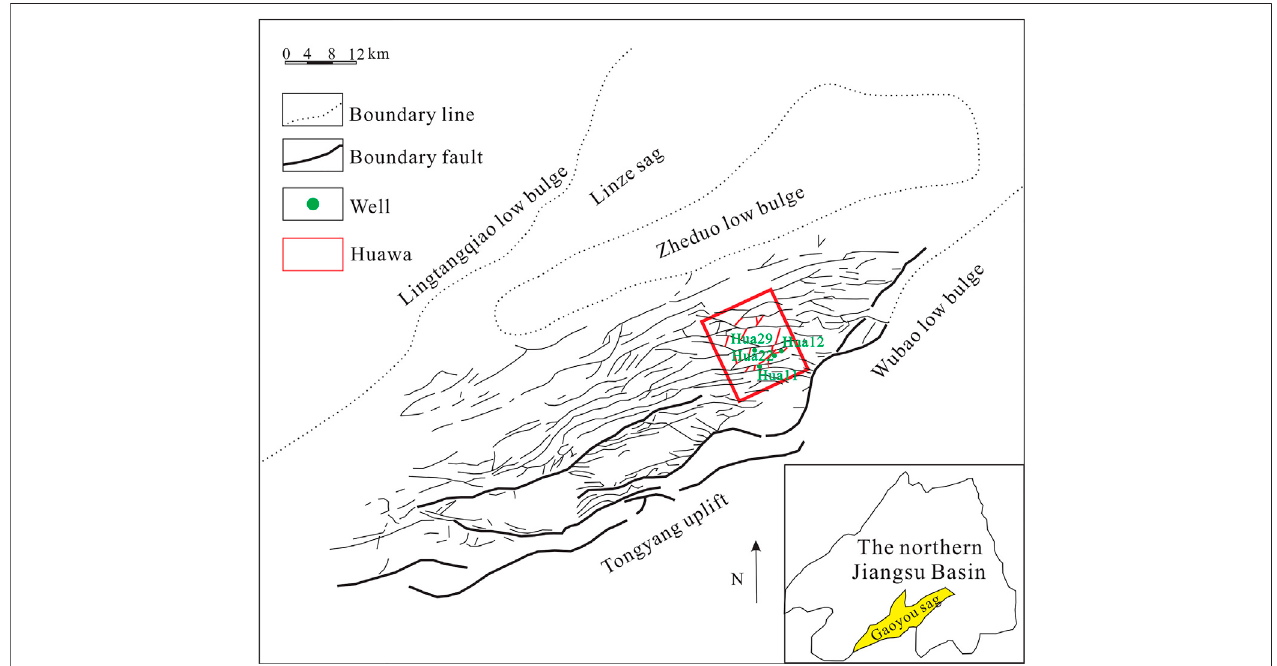
FIGURE 2 | Fault system distribution in the Gaoyou